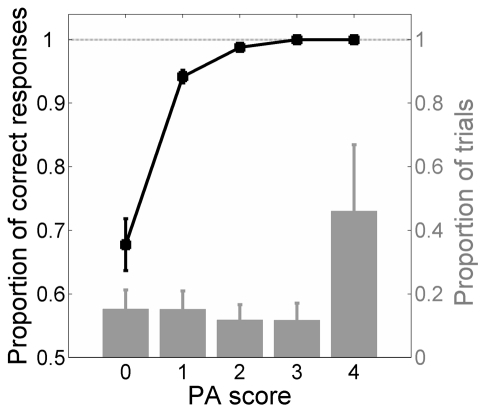
General relationship between motion discrimination and perceptual awareness.Black symbols: mean proportion of correct responses (chance level  = 0.5) at each PA score. The grey histogram represents the frequency distribution of PA scores. Data are collapsed over urgency and coherence (excluding coherence  = 0%). Bars: ± S.E.M. across subjects.